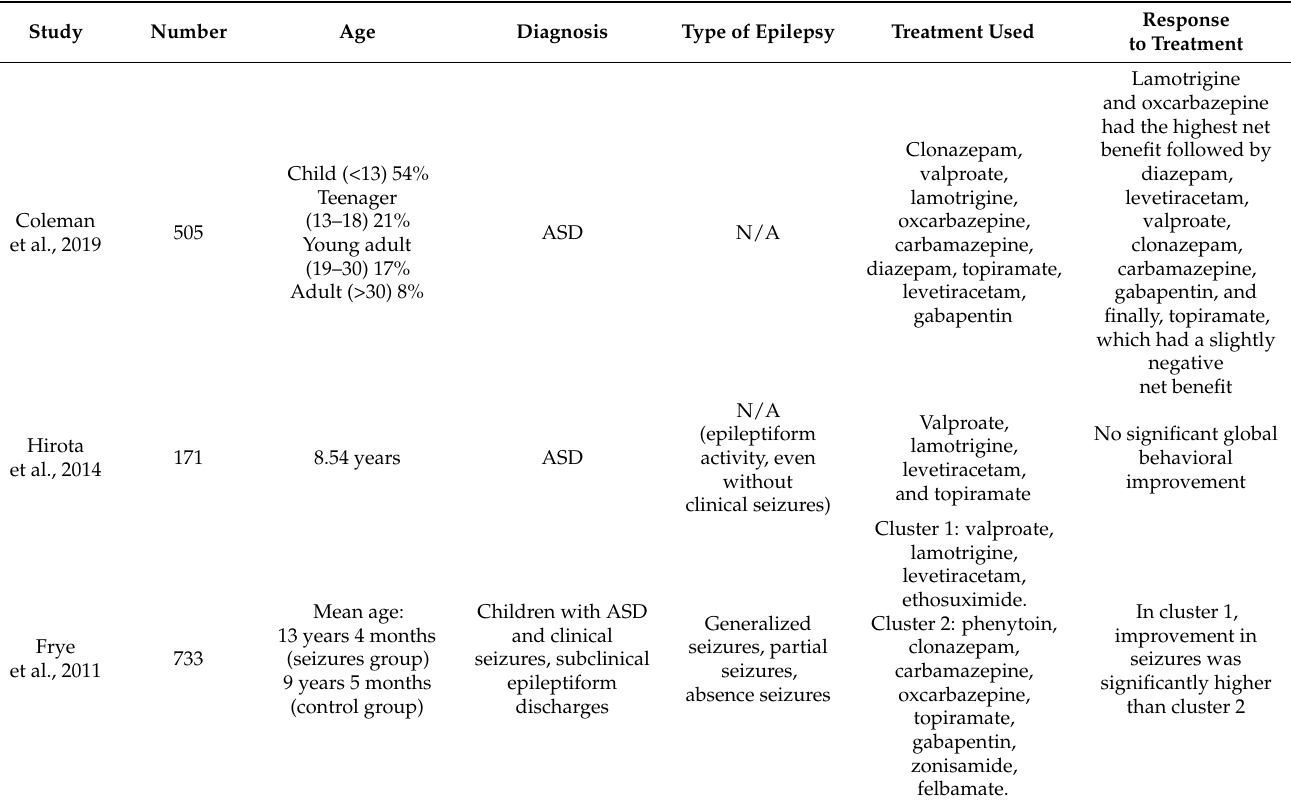
Table 3. Neuropsychopharmacology studies in ASD and